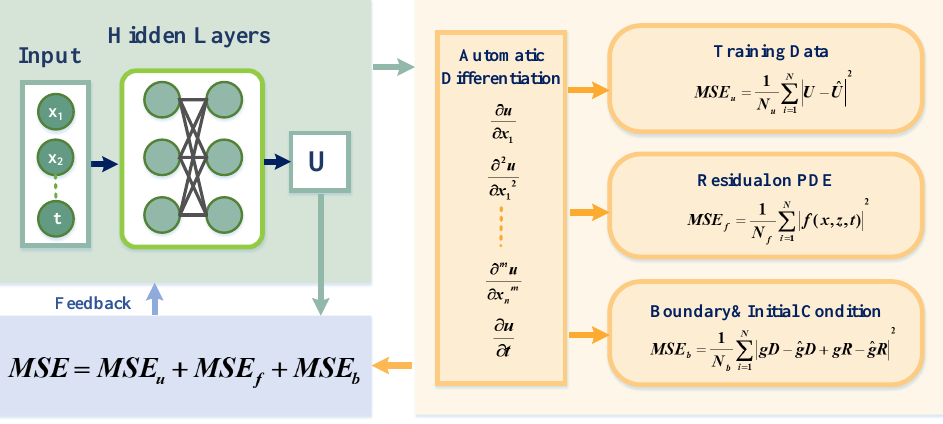
Figure 2. Illustration of a PINN algorithm for solving partial differential equations. This method uses AD technology to analyze and derive the integer derivative, and the obtained MSE is fed back to the neural